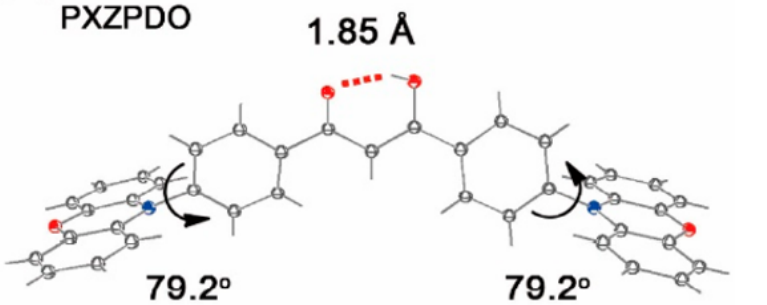
Figure 5. Efficiency scheme. TADF (thermally activated delayed fluorescence, ISC, intersection crossing). Yellow data are for PXZDO. Taken from Ref. [77] with permission from the American Chemical Society.